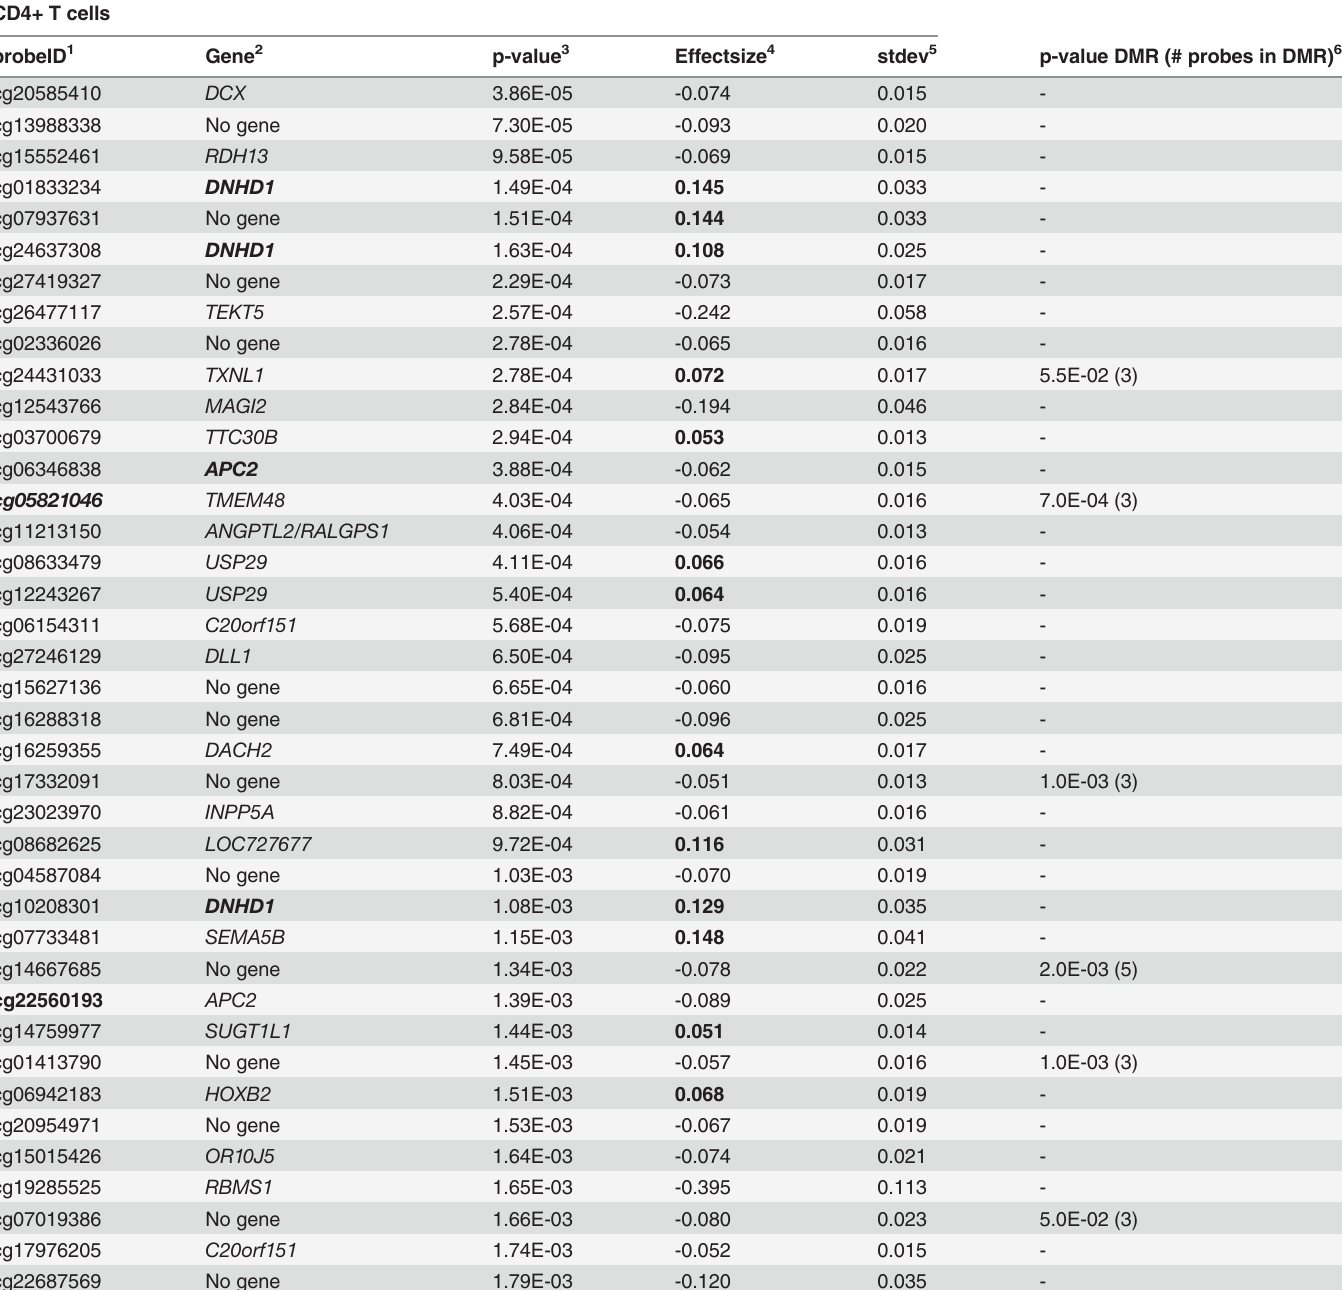
Table 2. Top 40 results sorted by p-values from linear regression analysis models of DNA methylation in CD4+ T cells. CD4+ T